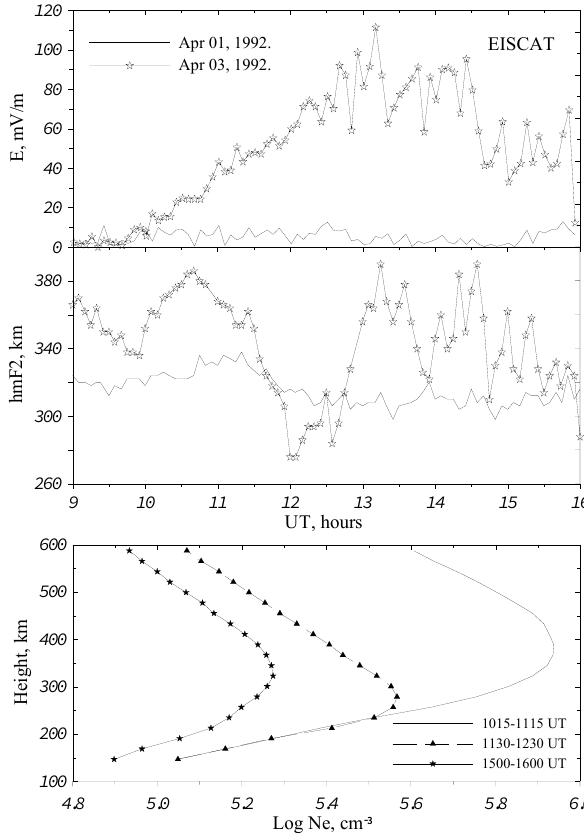
Fig. 8. The effect of electron precipitation decreasing hm F2 ob- served with EISCAT for a moderately disturbed day 19 November Fig. 8. 1987. A reference quiet day, 17 November 1987, is shown for a comparison. An intensive ionization in the lower part of the F2- region shifts the Ne(h) maximum to lower heights.